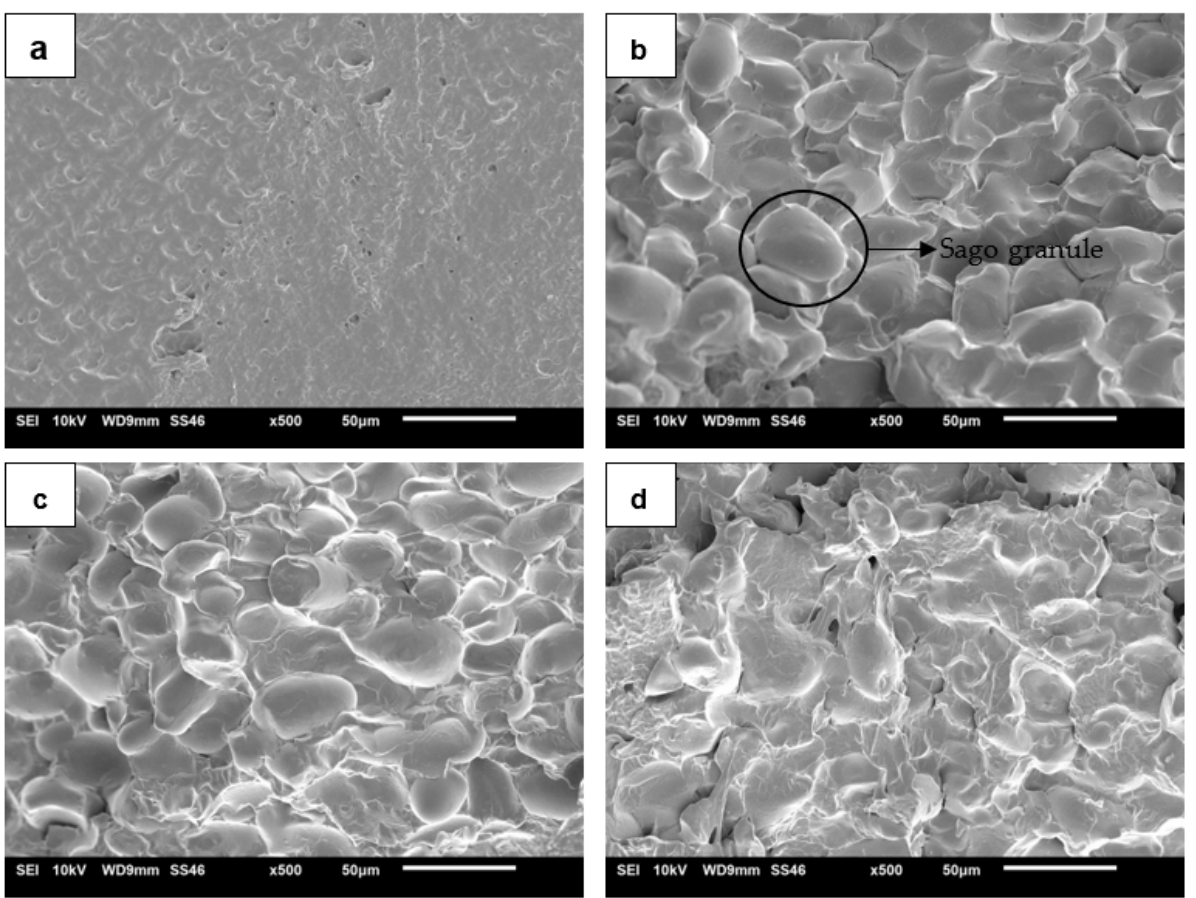
Figure 3. SEM micrograph of the fracture surface of TPSS with different ratios of agar: ( a ) 0 wt%, ( b ) 5 wt%, ( c ) 10 wt%, ( d ) 15 wt%.